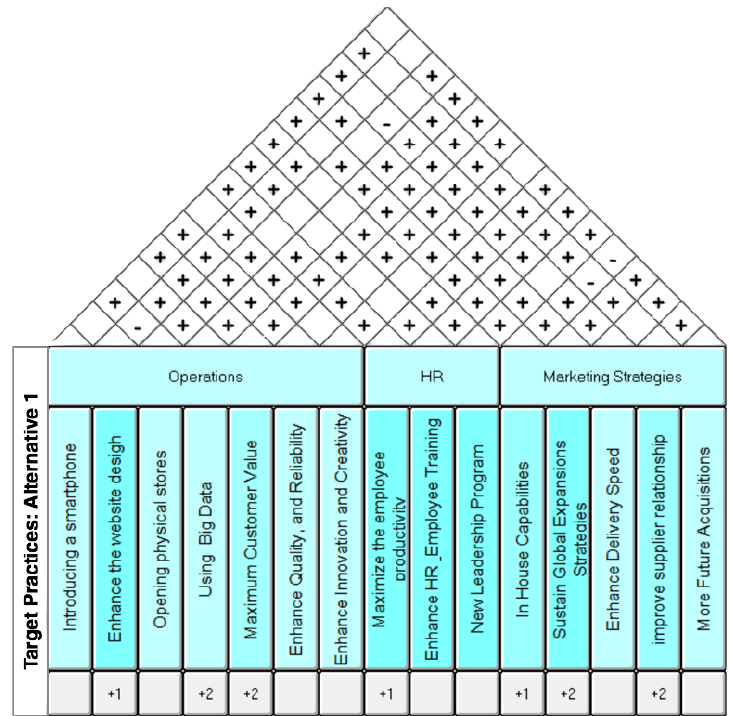
Fig. 10. Amazon Matrix of Change Target